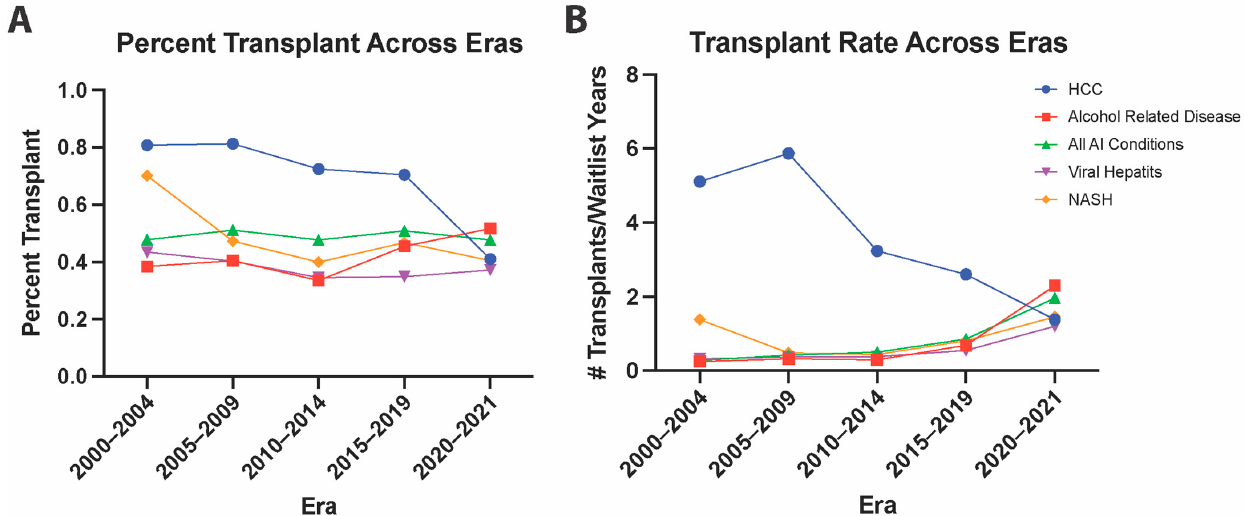
Figure 1. The 20-Year Trend in Transplantation for HCC, Alcoholic Cirrhosis, and Autoimmune Conditions, NASH, and Viral Hepatitis. The percent transplanted ( A ) or transplant rate ( B ) of patients listed with either HCC, Alcohol-Related Disease, Autoimmune Conditions, NASH, or Viral Hepatitis who were transplanted were graphed across each five-year era.